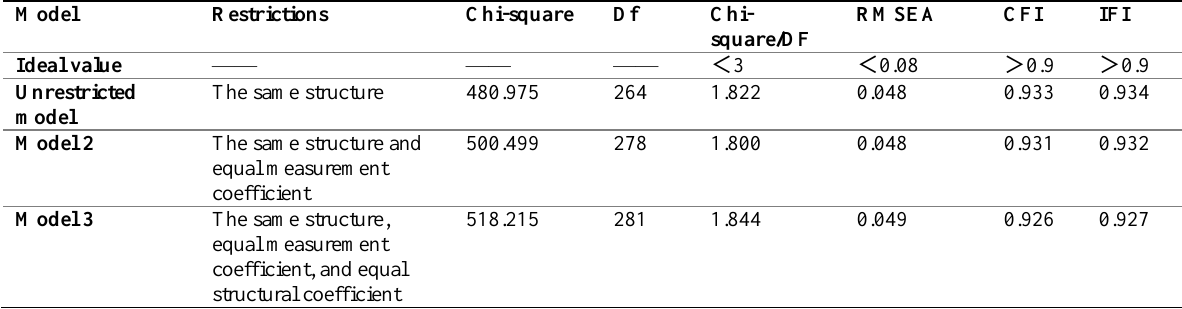
Table 14: Model fit index